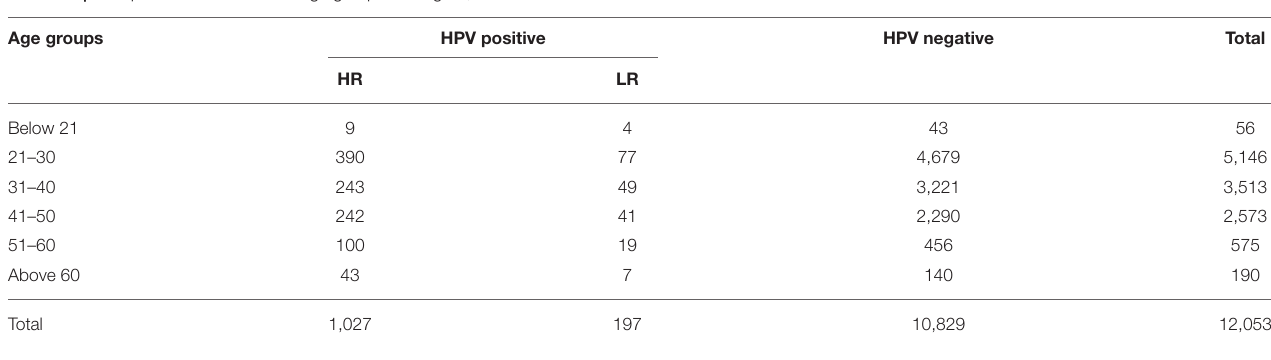
TABLE 1 | HPV prevalence of different age groups among 12,053 women. Age